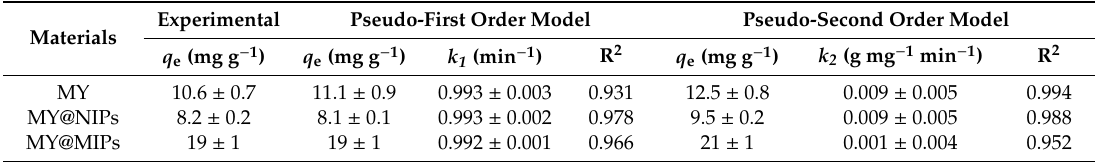
Table 2. Kinetic parameters corresponding to the adsorption of SMX onto MY, MY@NIPs, and MY@MIPs in ultrapure